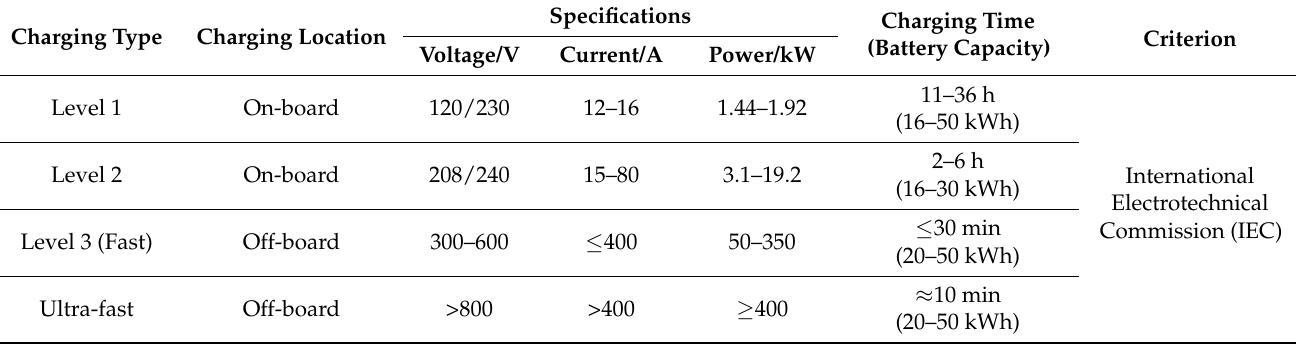
Table 1. Electric vehicle charging types and